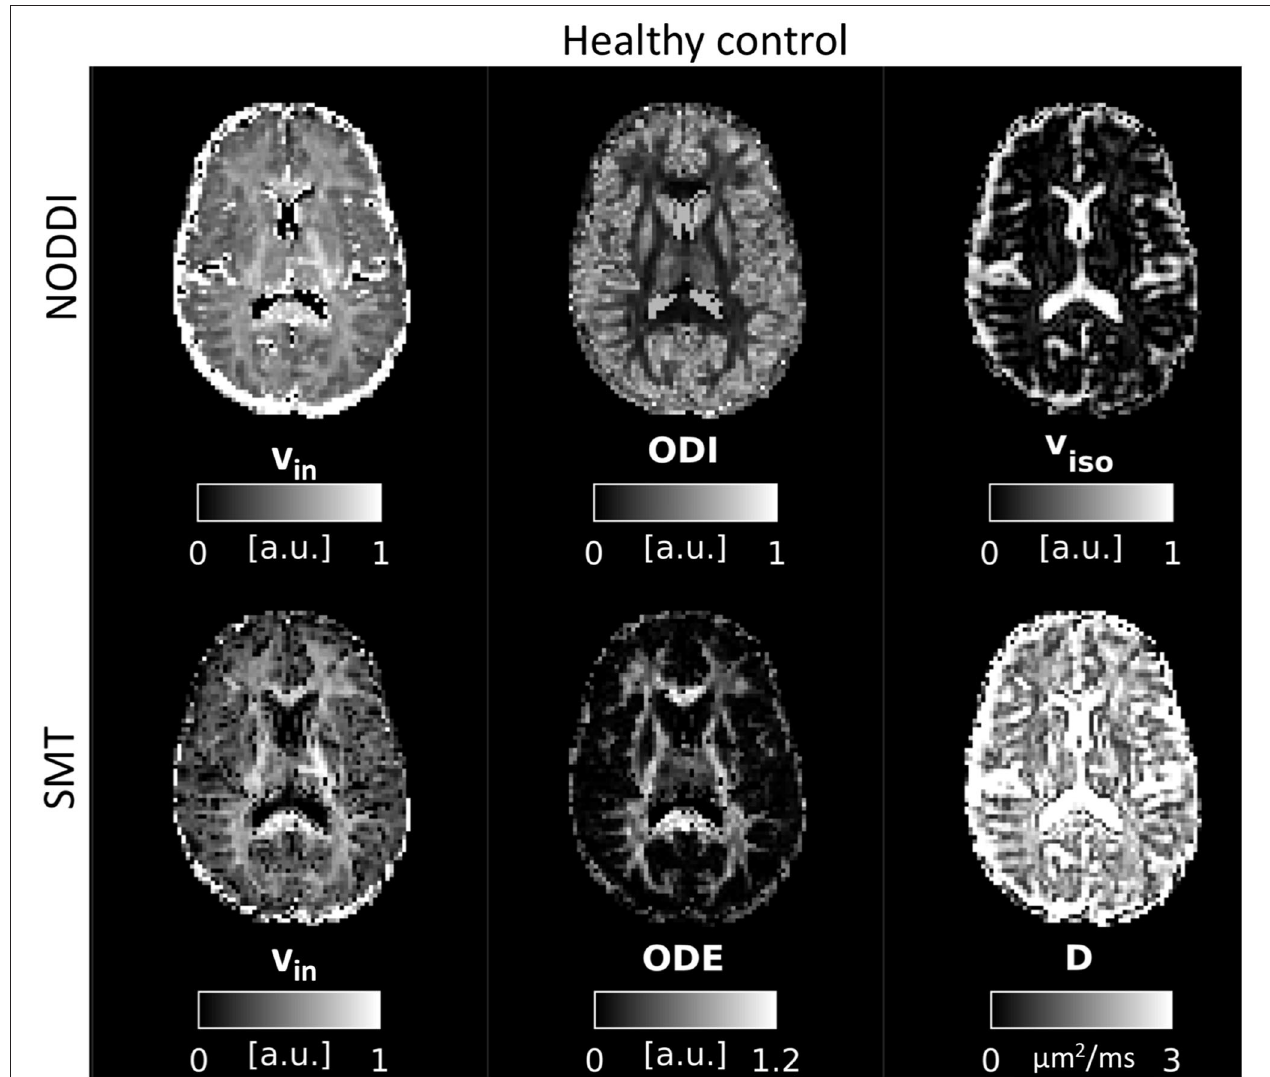
FIGURE 2 | NODDI and SMT metrics as obtained from a healthy control. Top : NODDI ( left : intra-neurite volume fraction v in ; orientation dispersion index ODI; isotropic volume fraction v iso ); bottom : SMT (intra-neurite volume fraction v in ; orientation dispersion entropy ODE; neural diffusivity